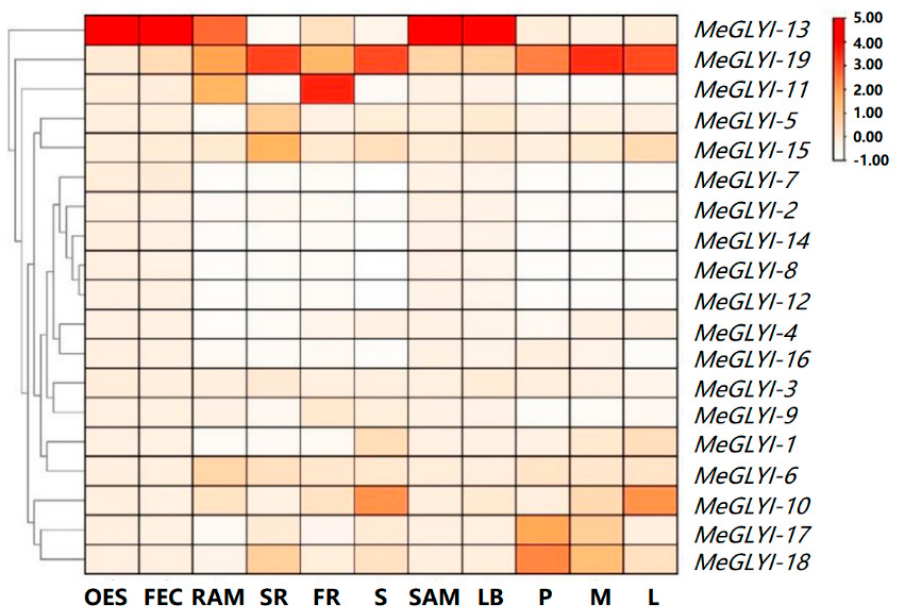
Figure 4. Expression analysis of the MeGLYI family genes in 11 tissues. OES, organized embryogenic structure; FEC, friable embryo callus; RAM, root apical meristem; SR, storage root; FR, fibrous root; S, stem; SAM, shoot apical meristem; LB, lateral bud; P, petiole; M, midvein; L,